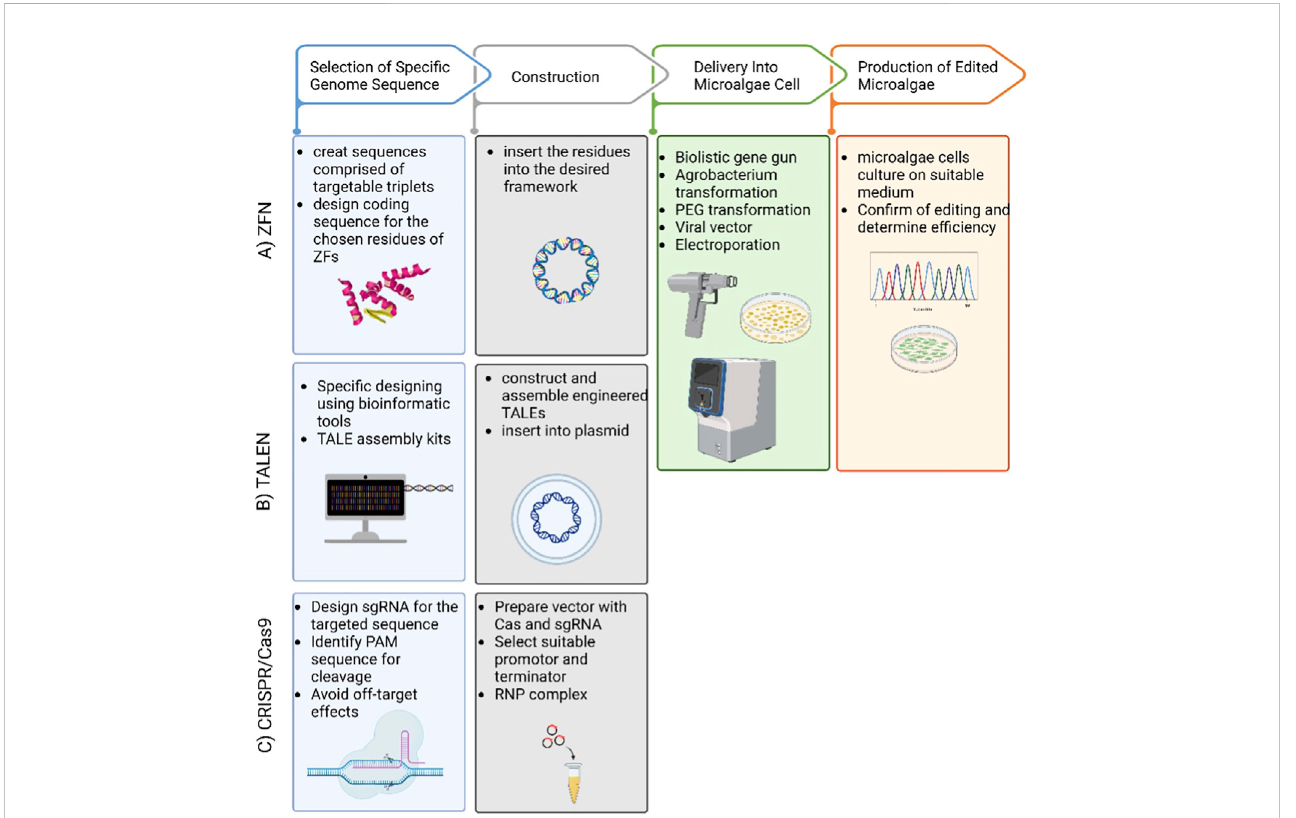
FIGURE 1 Simpli fi ed work fl ow for ZFN, TALEN and CRISPR/Cas9 mediated microalgae genome editing. (A) ZFN, (B) TALEN and (C) CRISPR/Cas9. The 3 tools have 4 steps (1) using bioinformatic tools to identify the targeted sequence and design accordingly, (2) construct the delivery method by choosing the vector, (3) select thedeliverymethod to insert theplasmid into themicroalgaecell, (4)subculture themicroalgaeonaselectivemedium and determinetheef fi ciency of gene